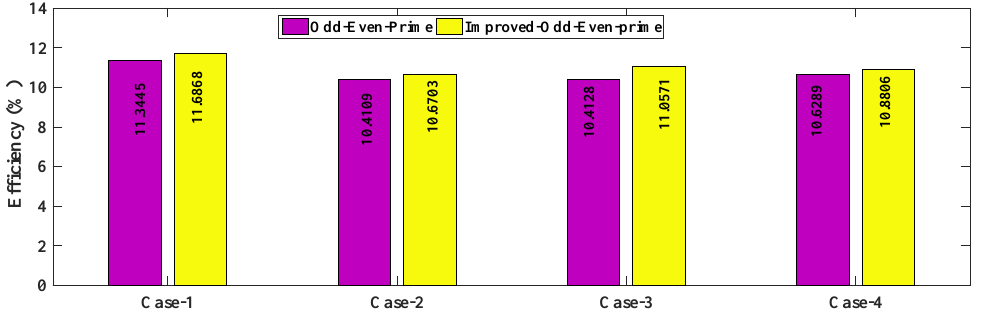
Figure 14. Efficiency for 9 × 9 PV array.